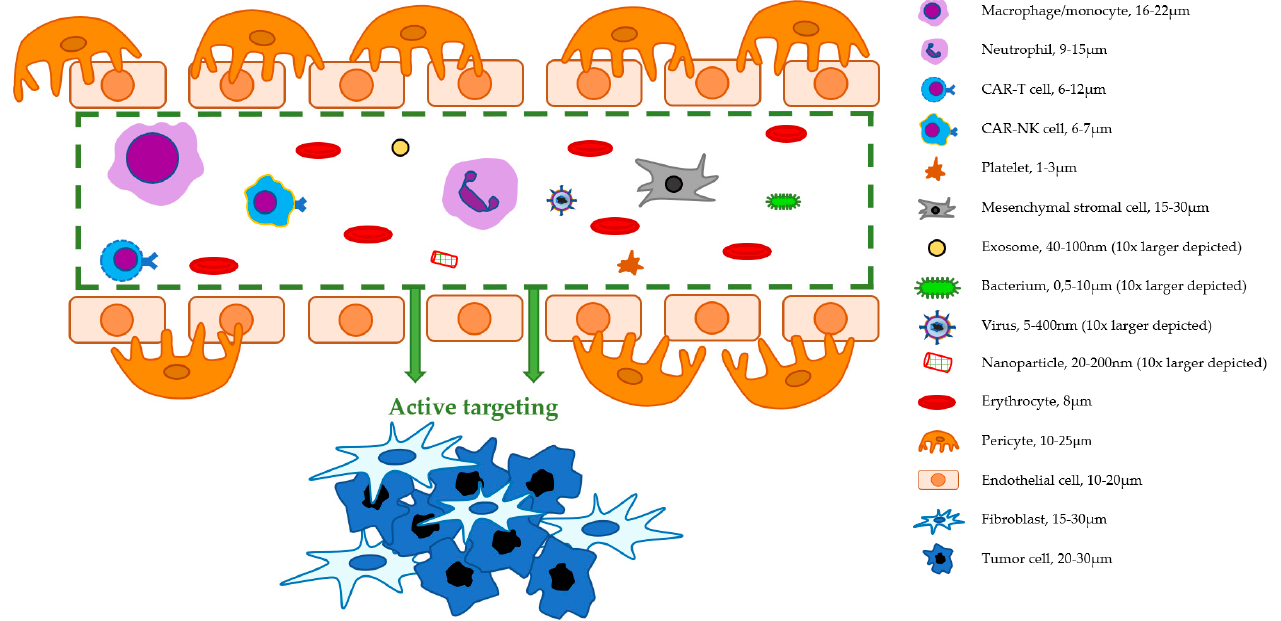
Figure 2. Schematic overview of cell- and nanoparticle-based IGS tracers in a blood vessel near tumor tissue. Sizes of possible IGS tracers differ substantially. Logically, they rely on different mechanisms to reach their target tissue.